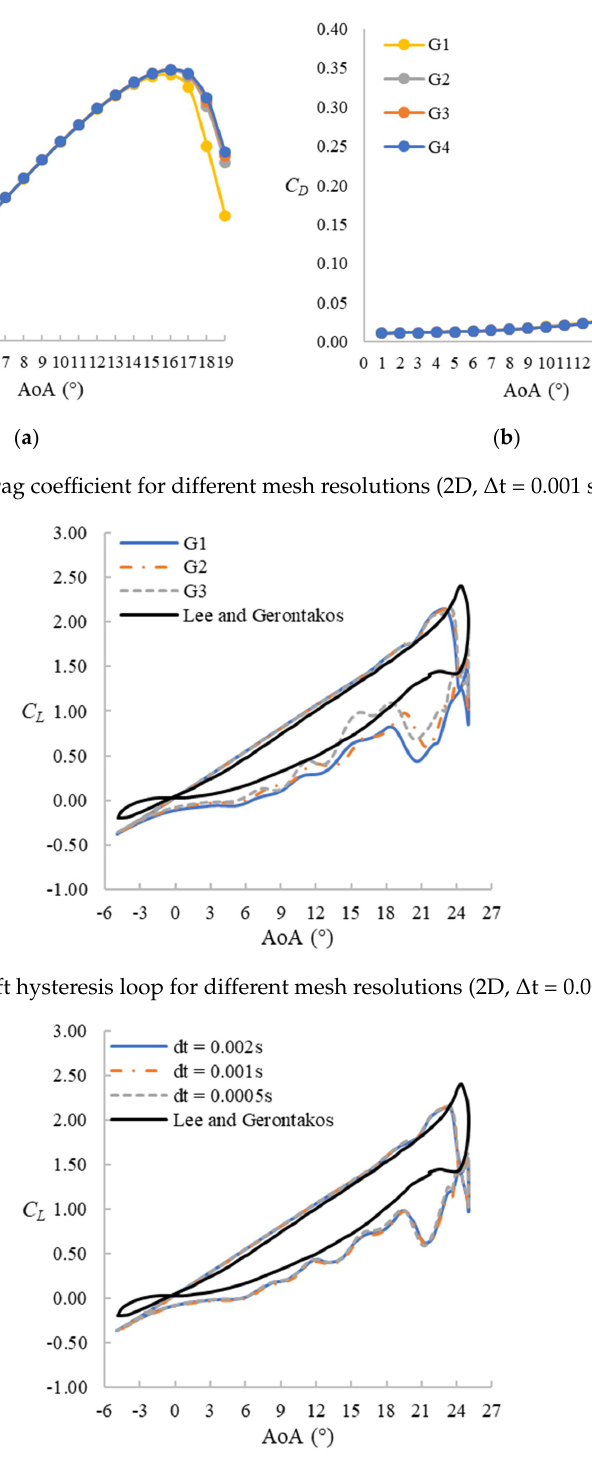
Figure 5. Lift hysteresis loop for different time step sizes (2D, original mesh G2).